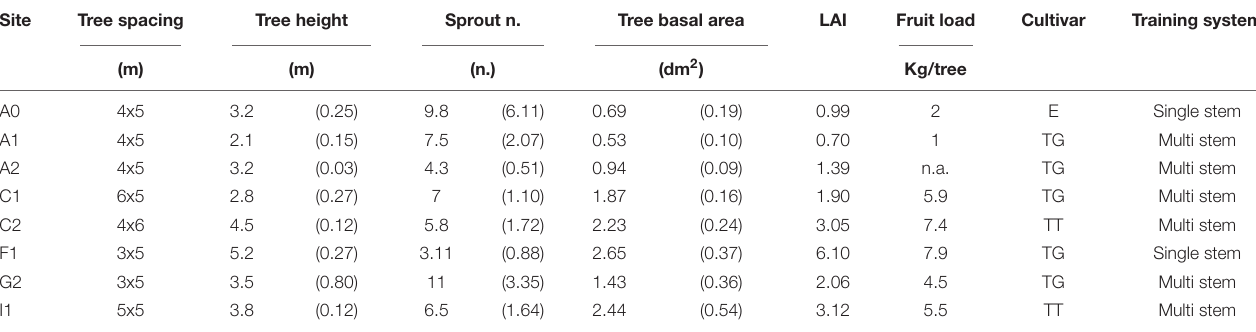
TABLE 1 | Tree biometrics in the study areas: tree spacing, estimated tree height, sprout number per individual tree, total basal area (SD in brackets), estimated leaf area index (LAI), fruit load (maximum value recorded in the period), cultivar (TG, Tonda di Giffoni; TT, Tonda Trilobata; E, Ennies), and training system. Site Tree spacing Tree height Sprout n.